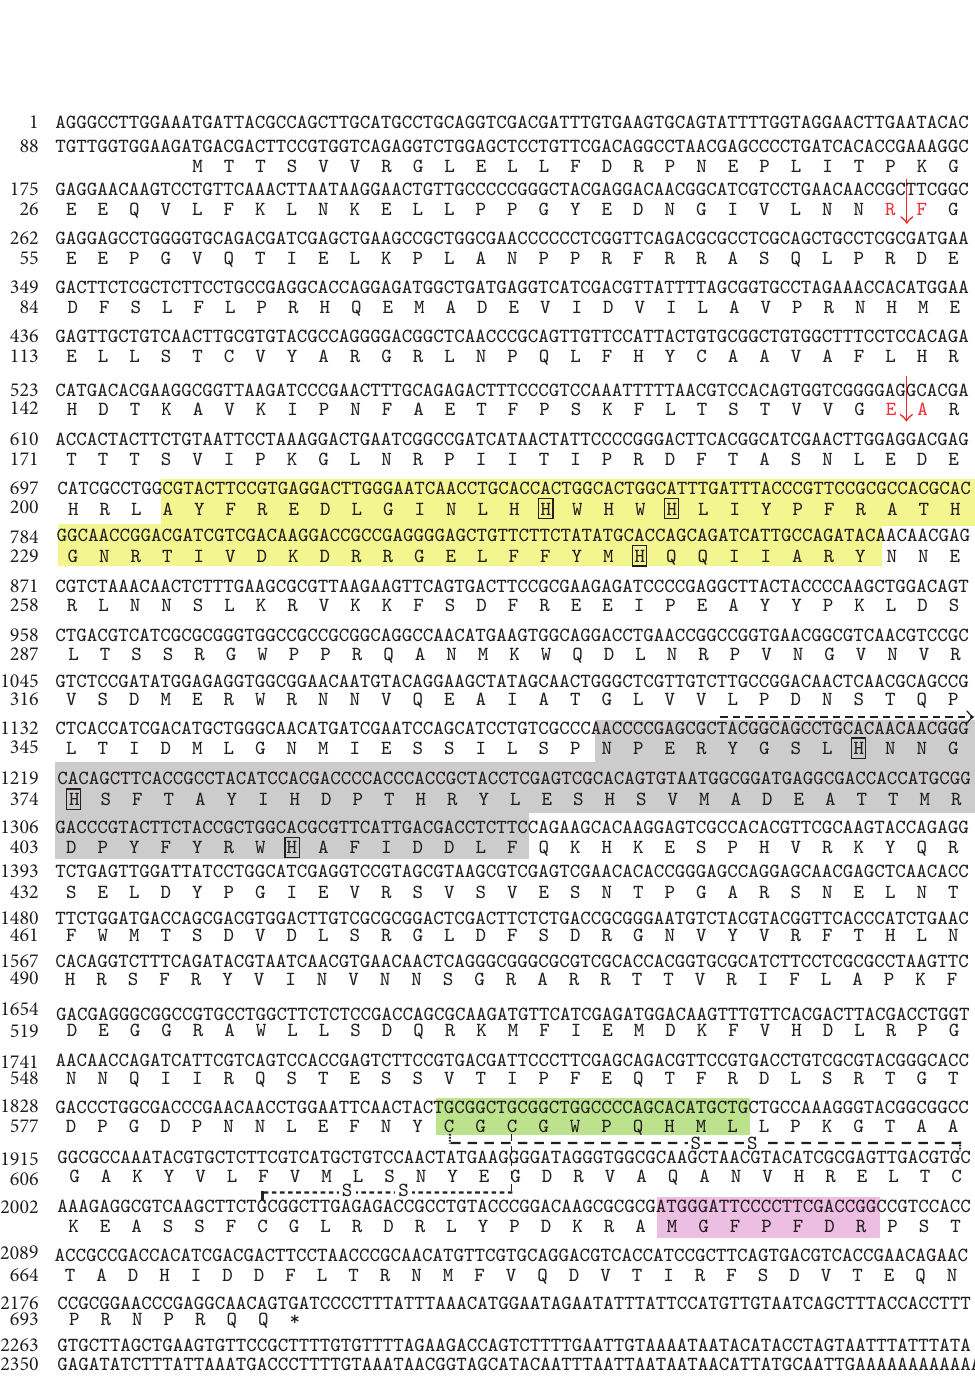
Figure 2: Nucleotide and amino acid sequence of O. furnacalis PPO3 . The deduced amino acid sequences are shown below the nucleotide sequence of PPO3 (NCBIaccession number: KX437621). Nucleotides arenumbered fromthefirstbaseat the5 󸀠 -end. Amino acid residueswere numbered from the initiating methionine. The one-letter code for each amino acid is aligned with the second nucleotide of the corresponding codon. The stop codon is marked with asterisk. The cDNA fragment from 3 󸀠 -RACE started from the dashed-line arrow to the end. The predicted proteolytic cleavage bonds are shown in red and marked with red arrow. The potential copper binding site A (CuA), copper binding site B (CuB), the putative thiol ester sites, and a conserved motif at the C-terminus are shaded in yellow, grey, green, and purple, respectively. The six histidine residues absolutely conserved within the CuA and CuB are in the square boxes. Two predicted disulfide linkages are represented by dashed